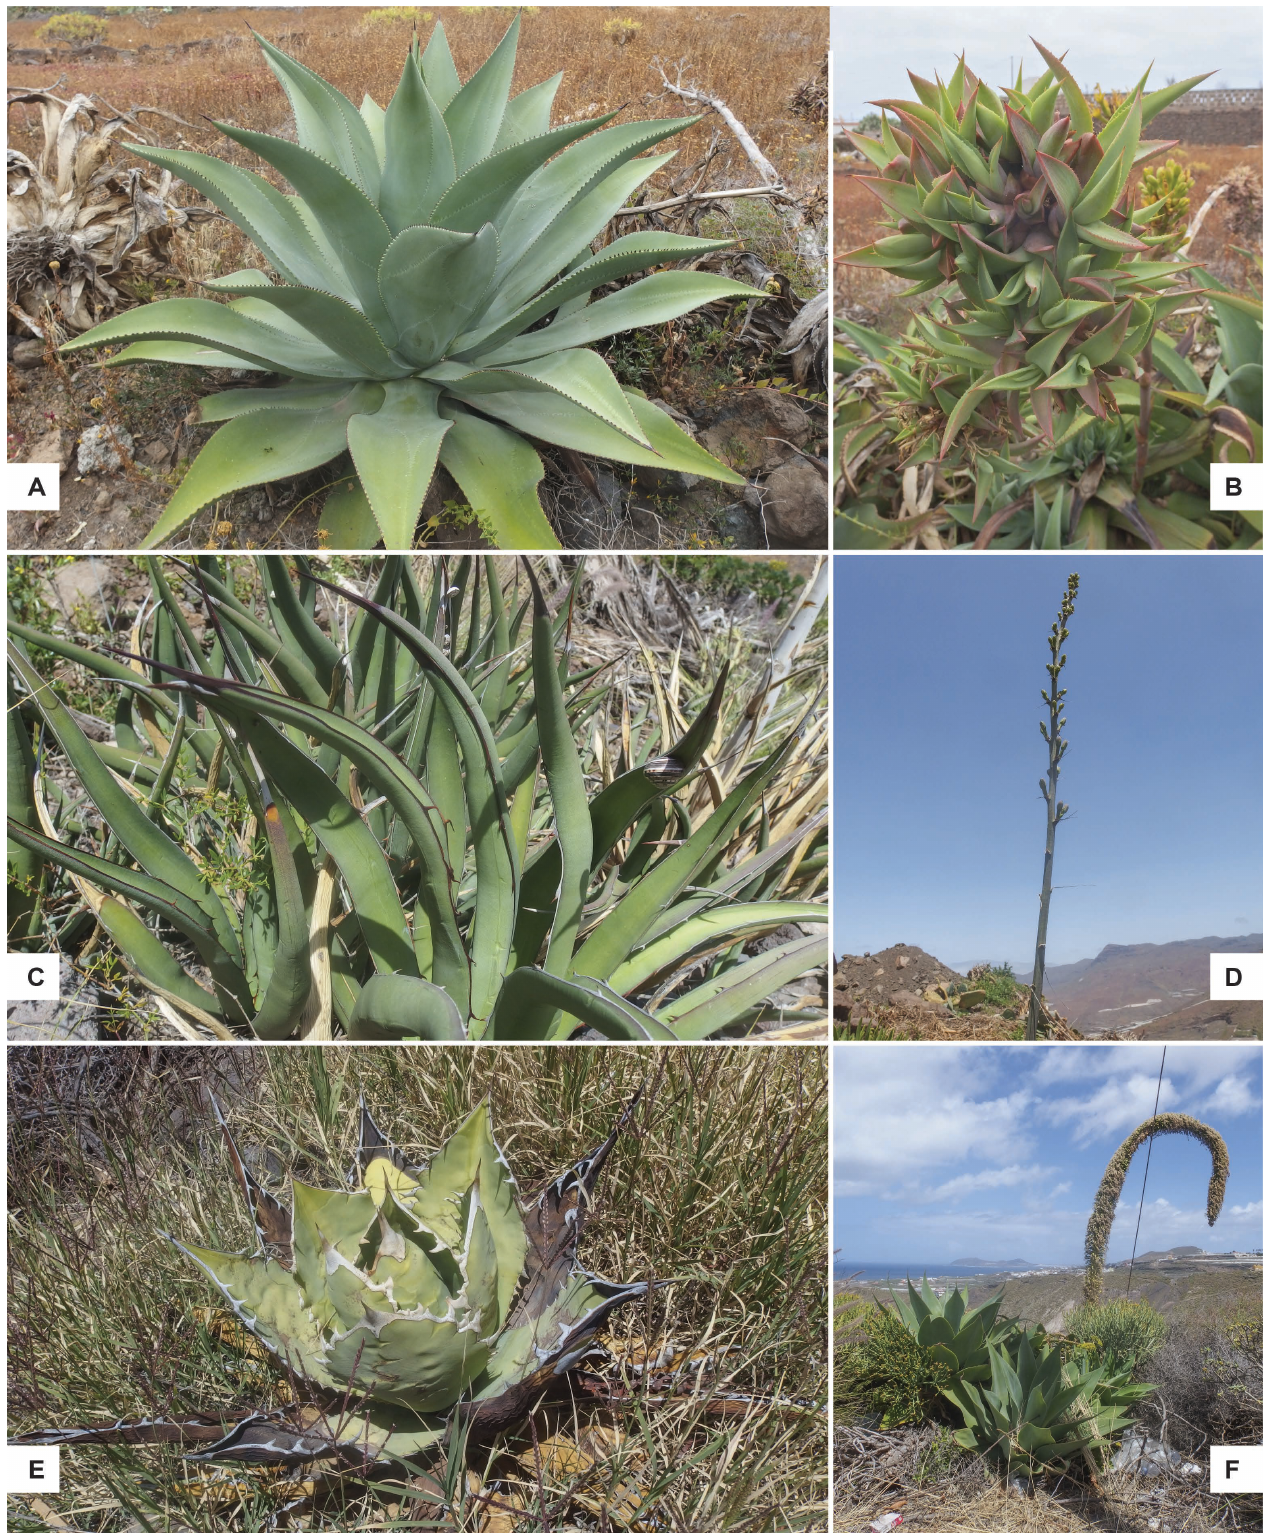
Figure 6 – A . Agave vivipara , Arucas (C), April 2018. Leaves are abruptly narrowed towards base. B . Idem. Inflorescences are bulbiliferous. C . A. lechuguilla , La Aldea de San Nicolás (C), April 2018. D . Idem. The inflorescence of this species is spicate, not racemose. Bracts are linear. E . A. oteroi , Santa Lucía de Tirajana (C), April 2018. F . A. attenuata , Firgas (Cambalud) (C), April 2018. The arching,